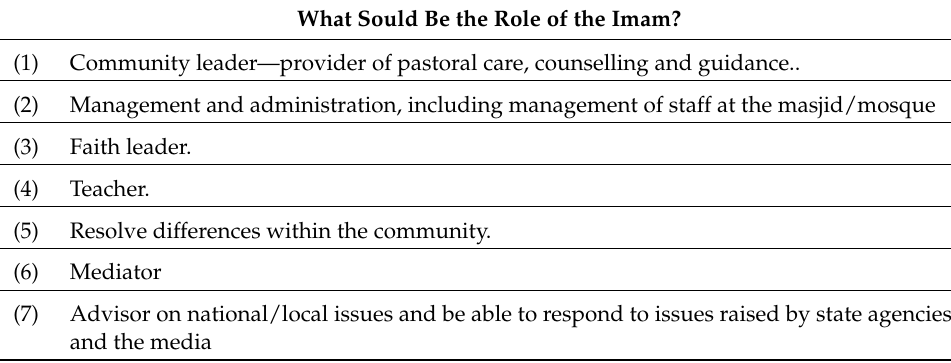
Table 5. Interpretative content analysis Delphi 3. Workshop question